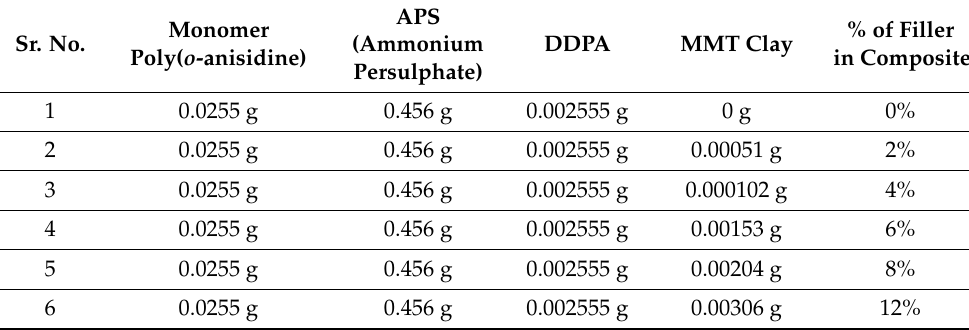
Table 1. Scheme of nanocomposite